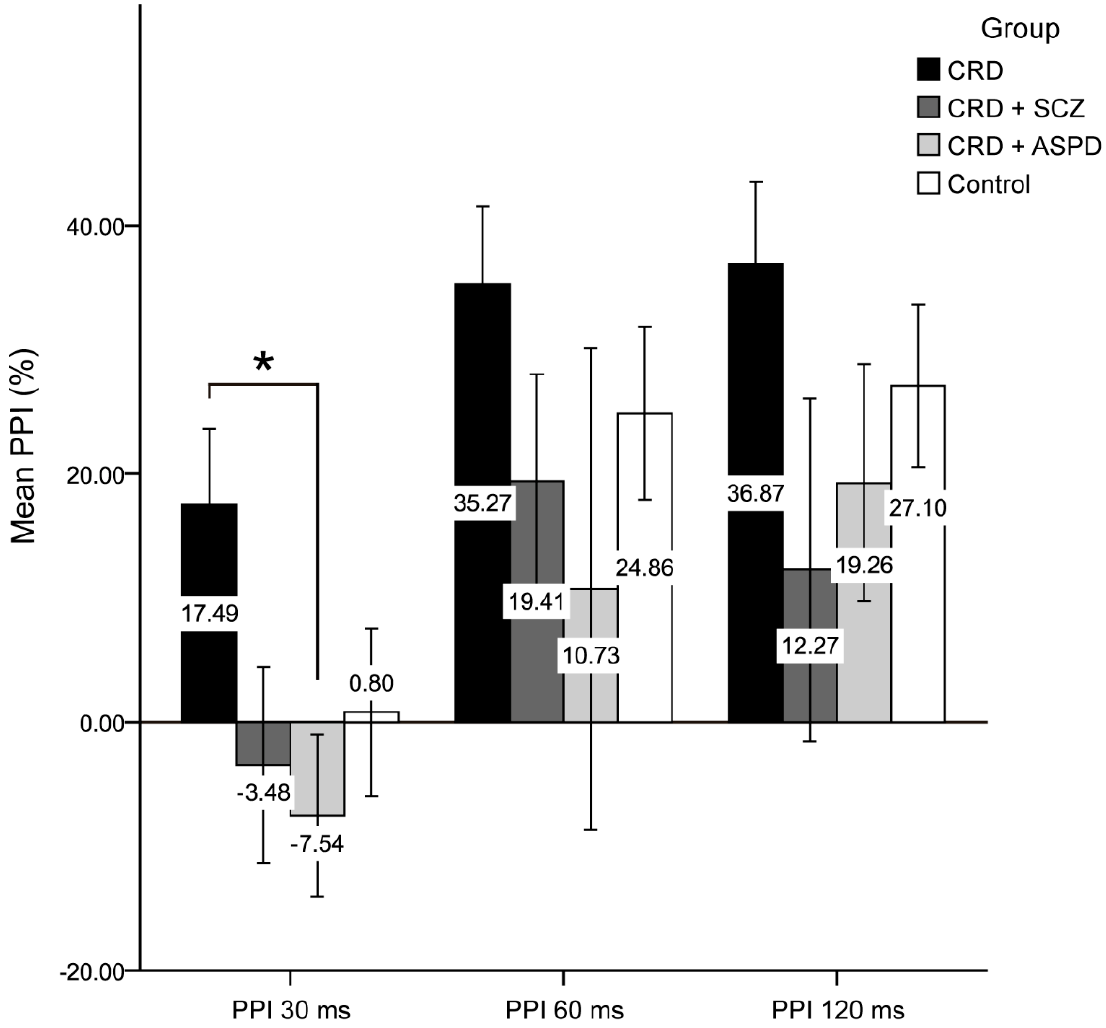
Figure 2. Prepulse inhibition percentage. CRD: cocaine-related disorder; SCZ: schizophrenia; APD: antisocial personality disorder; PPI: prepulse inhibition; ms: milliseconds. Data are shown as the mean ± standard deviation (* p < 0.05).